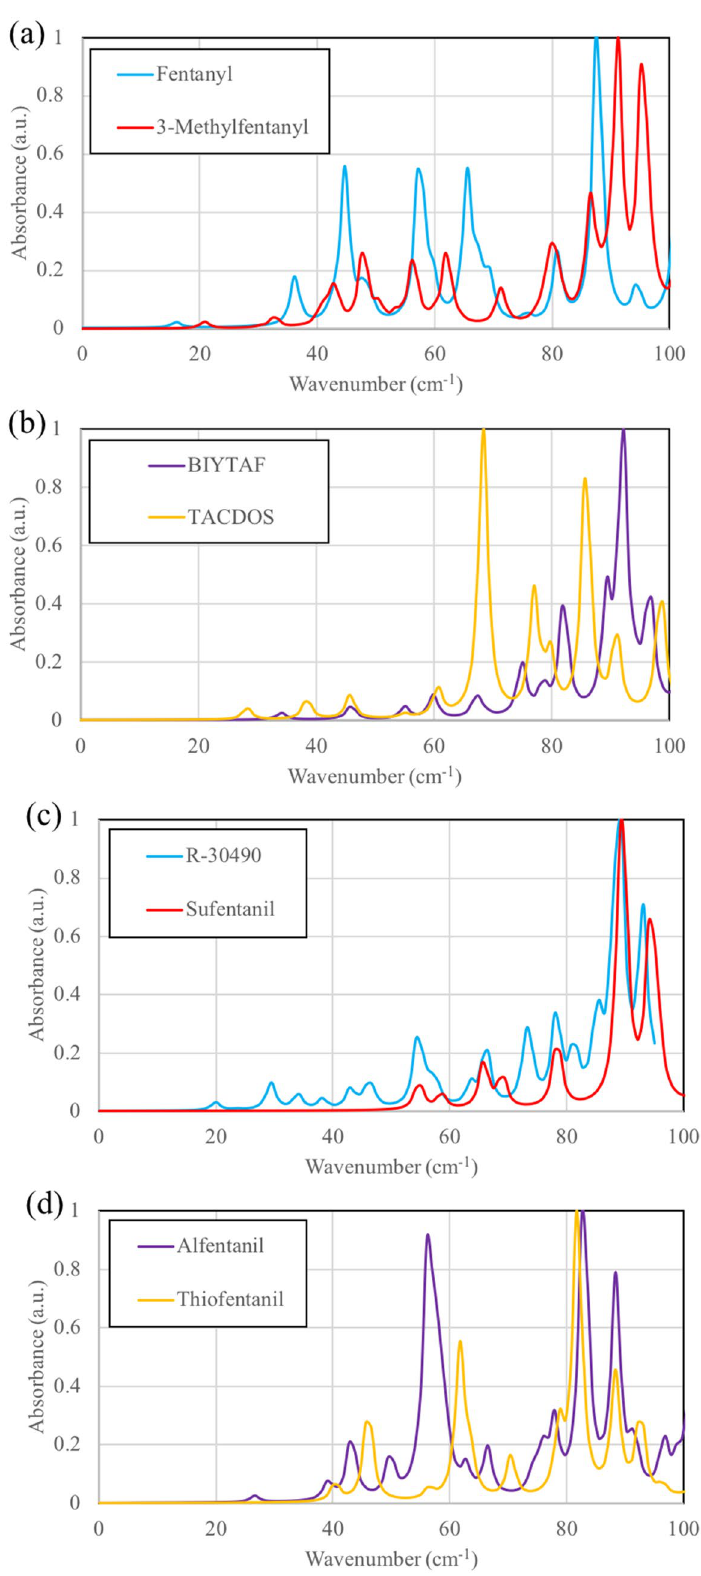
Figure 2. THz spectra of ( a ) fentanyl and 3-methylfentanyl, ( b ) BIYTAF and TACDOS, ( c ) R-30490 and sufentanil, and ( d ) alfentanil and